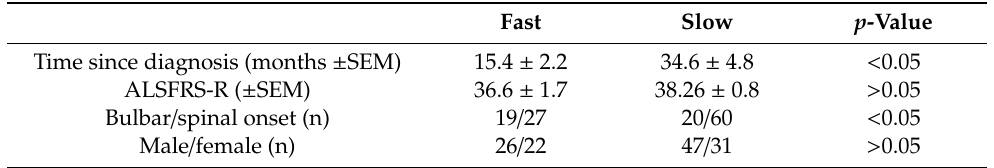
Table 1. Demographic characteristics of the